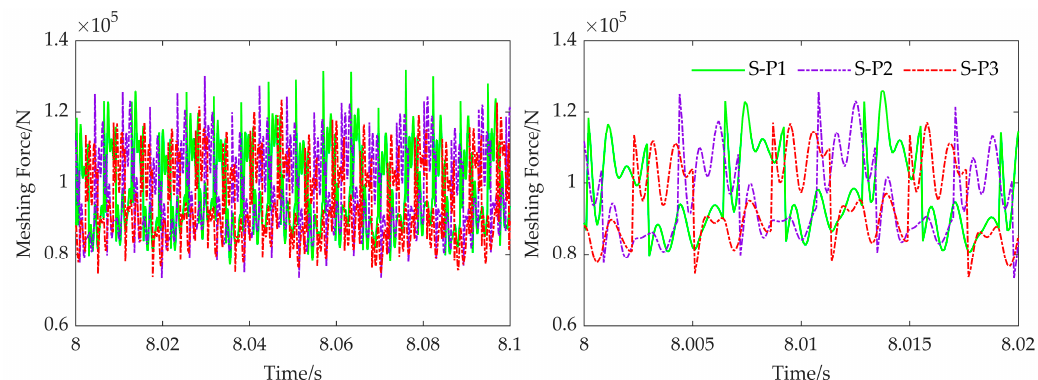
Figure 12. Meshing force between the sun and the three planet gears of the HSP.